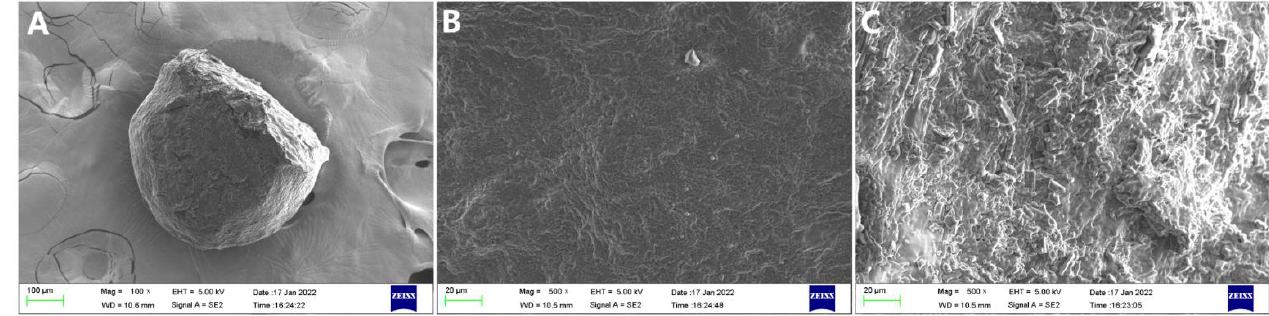
Figure 3. SEM image of ( A , B ) appearance of microsphere, ( C ) cross section of microsphere.